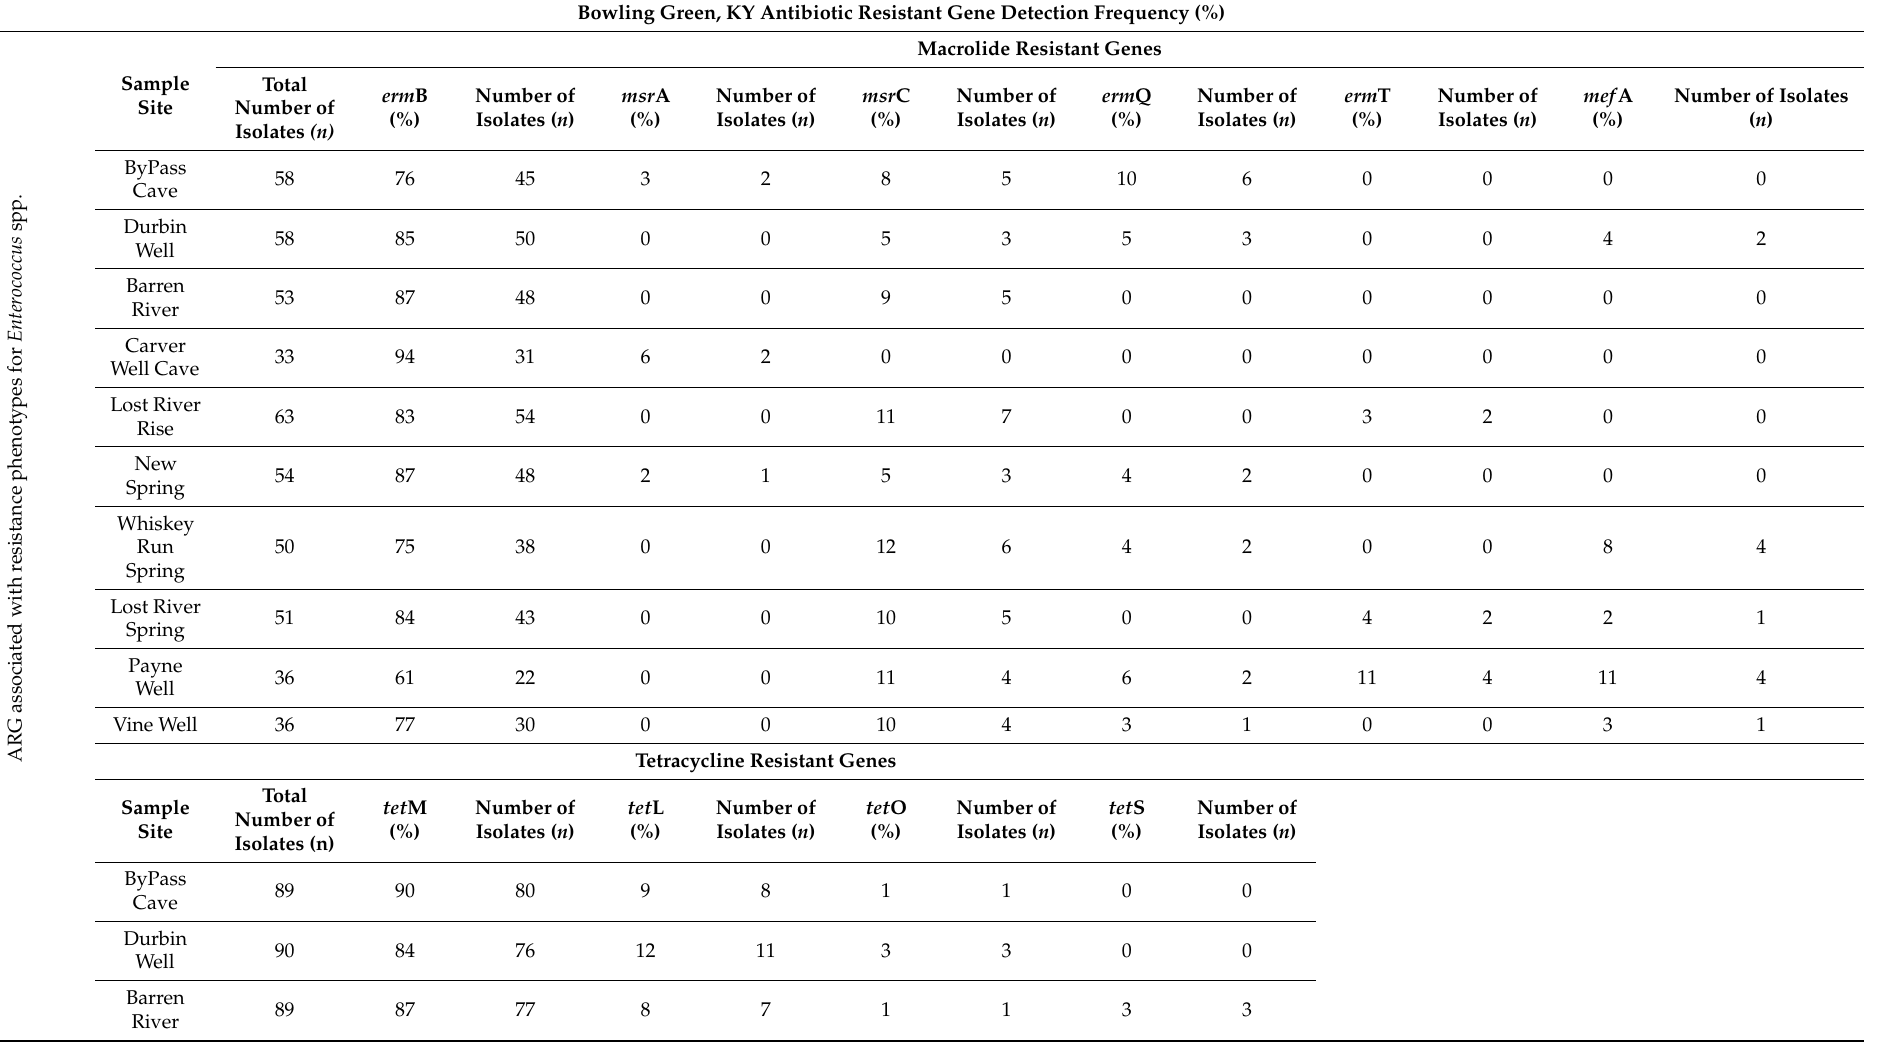
Table 3. Total detection frequencies of ARGs for resistance phenotypes of Enterococcus spp. and E. coli